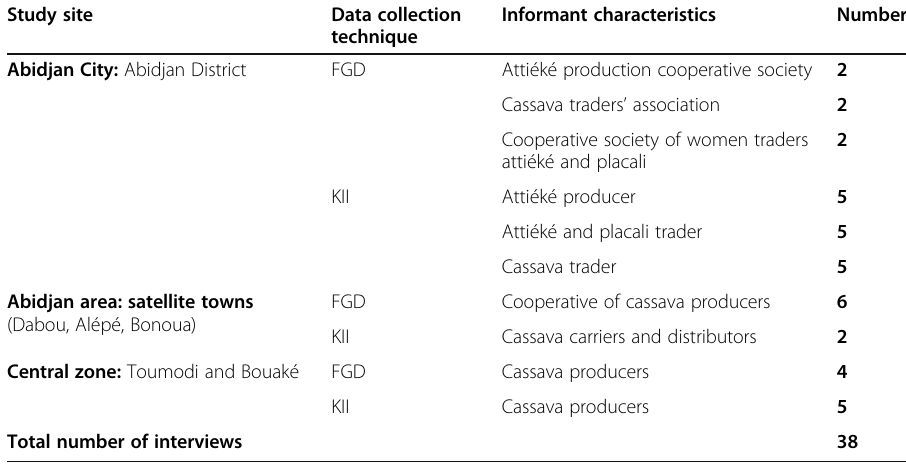
Total number of interviews